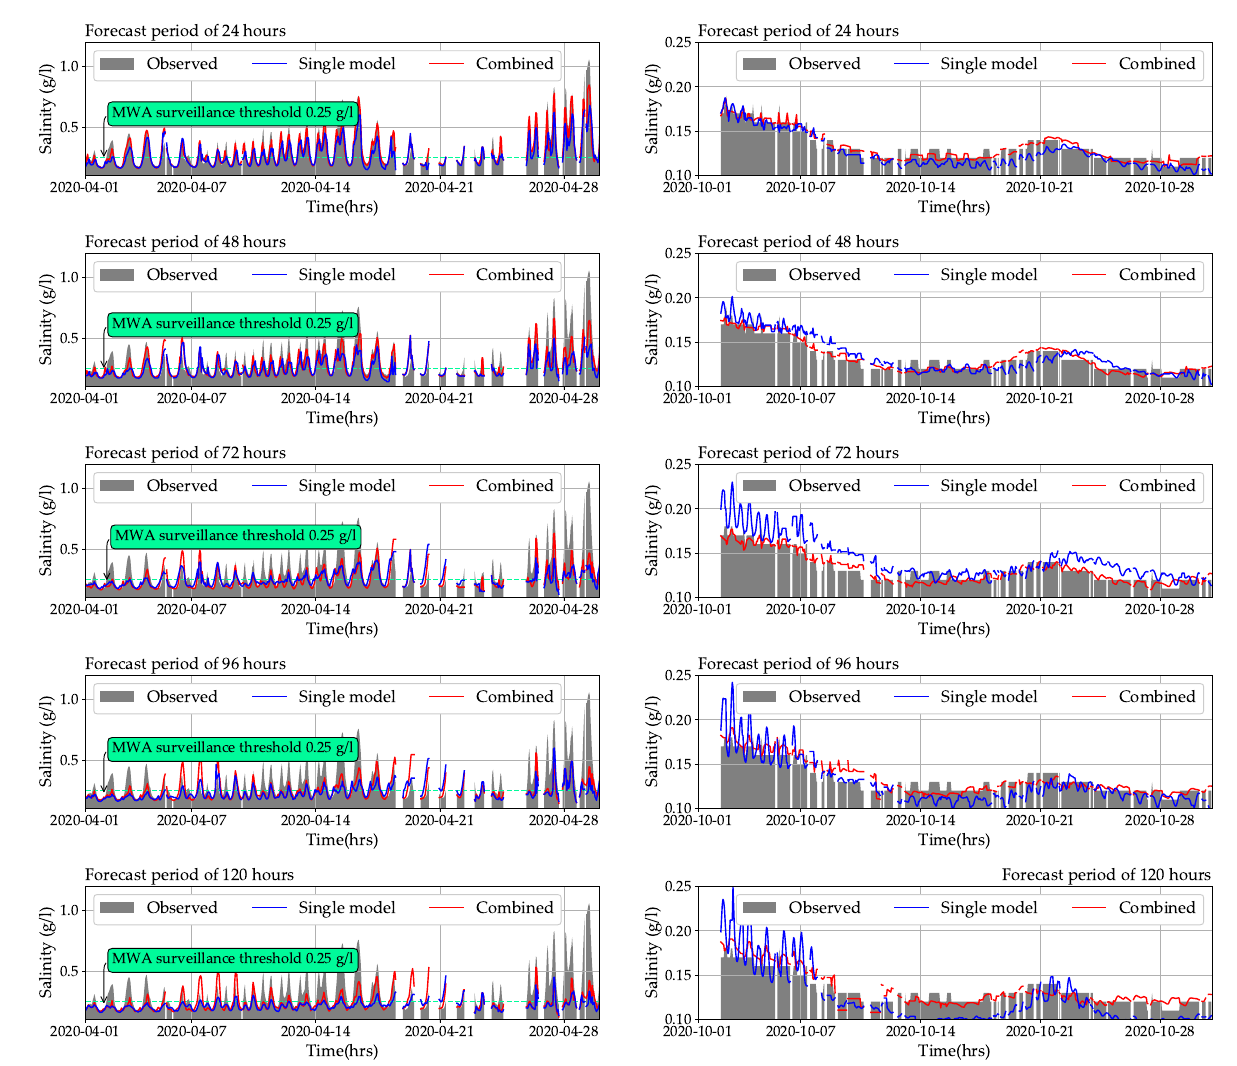
Figure 7. The continuous salinity forecast with real data (testing period). The salinity observed and forecasted with forecast periods from 24 to 120 h of the selected ANN combined model and single model are